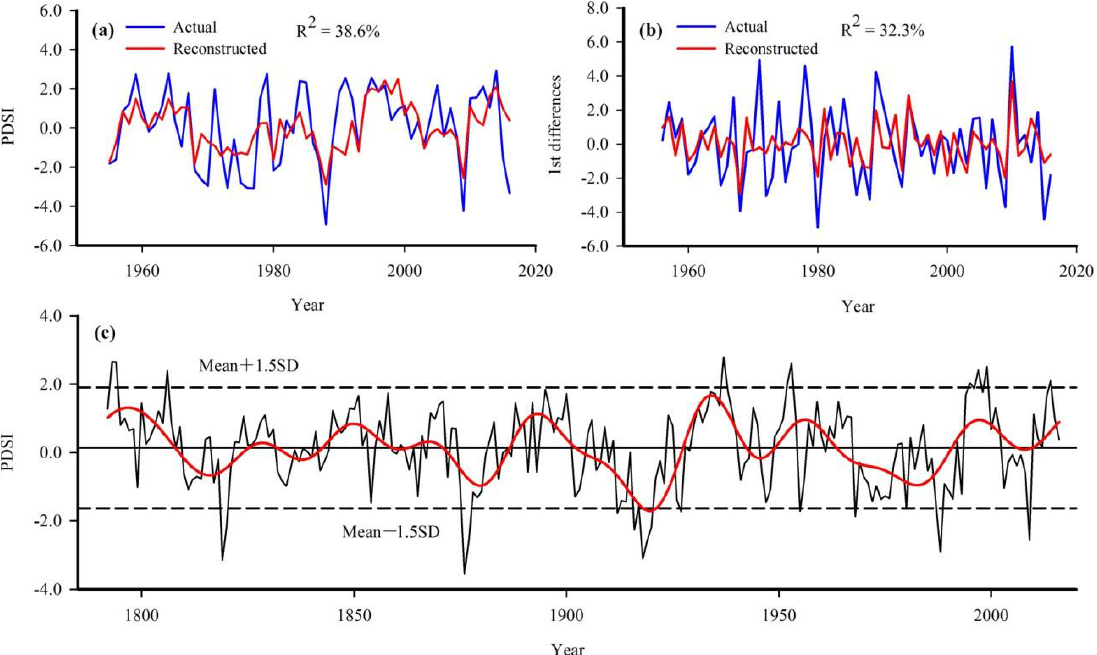
Figure 6. Comparisons between reconstructed and observed PDSI p6-7 ( a ) and the comparison between the first-order difference during 1955–2016 ( b ); and the reconstruction of PDSI p6-7 over the period 1792–2016 (( c ); the black curve). Bold red line represents the 20-year fast Fourier transform (FFT) low-pass filter. The central horizontal solid line shows the mean of the reconstructed values and the short dash line represents mean ± 1.5 standard deviations.